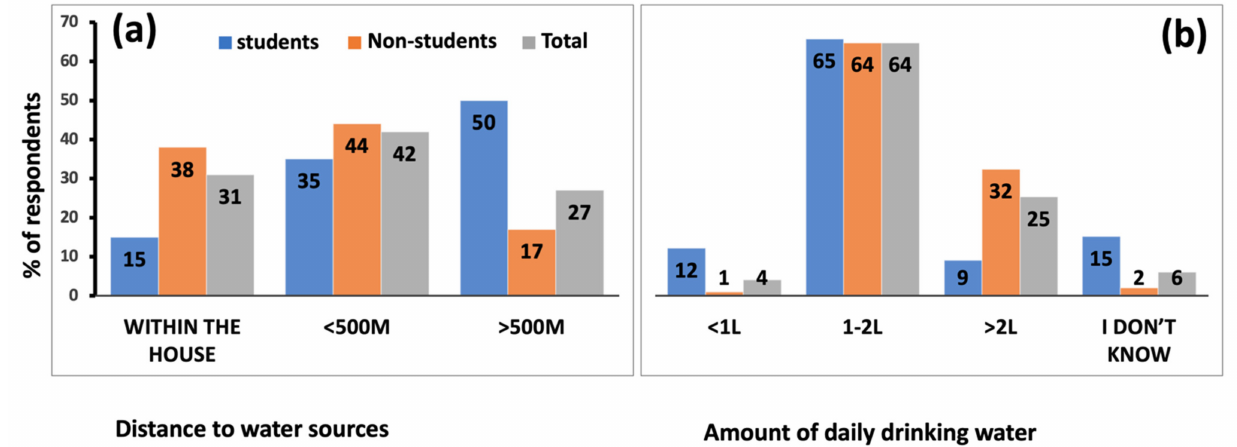
Figure 3. The percentage of respondents and the distance to their drinking water sources ( a ) and the amount of daily drinking water ( b ) in the Makindu–Kibwezi area of Makueni